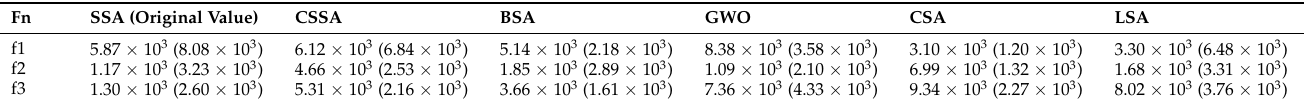
Table 5. Comparison of the mean error and standard deviation of the test function values. (50